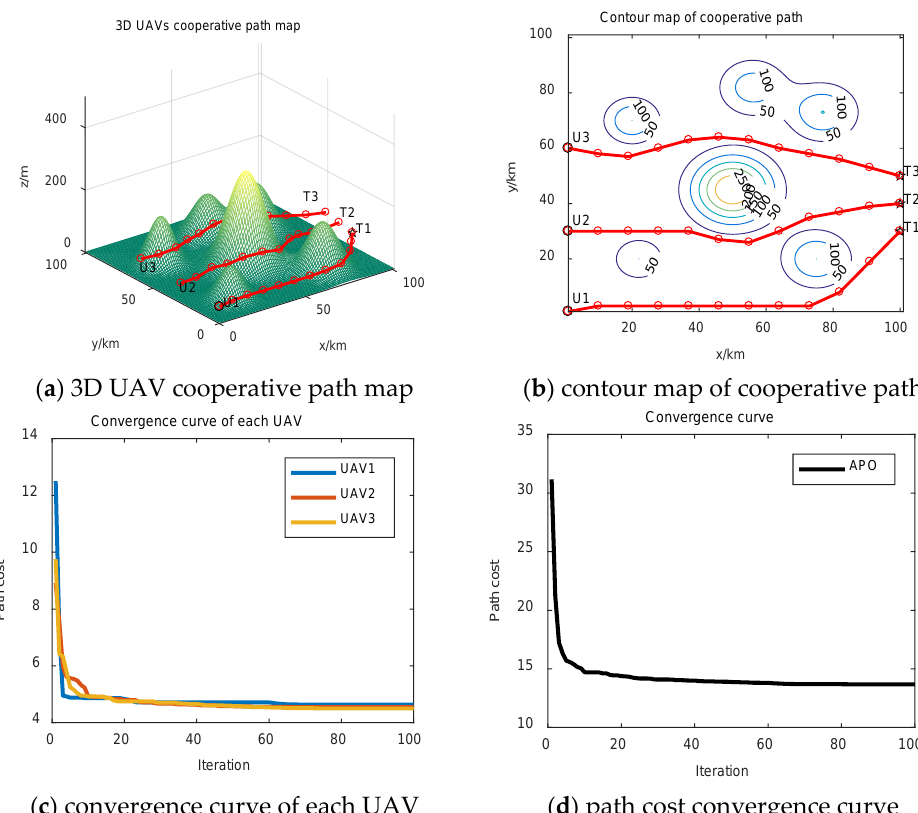
Figure 8. The result of case 1. ( a ) 3D UAV cooperative path map; ( b ) contour map of cooperative path; ( c ) convergence curve of each UAV; ( d ) path cost convergence curve. Table 10. Range and flight time of each aircraft (case